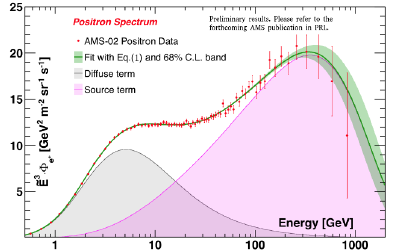
Figure 3. The fi t of Eq.1 (green line) to the positron fl ux in the energy range [1 - 1000] GeV together with the 68% CL inter- val (green band). The red dots represent the measured average positron fl ux values over the measurement period scaled by E 3 . The source term contribution is represented by the magenta area, and the di ff use term contribution by the grey area